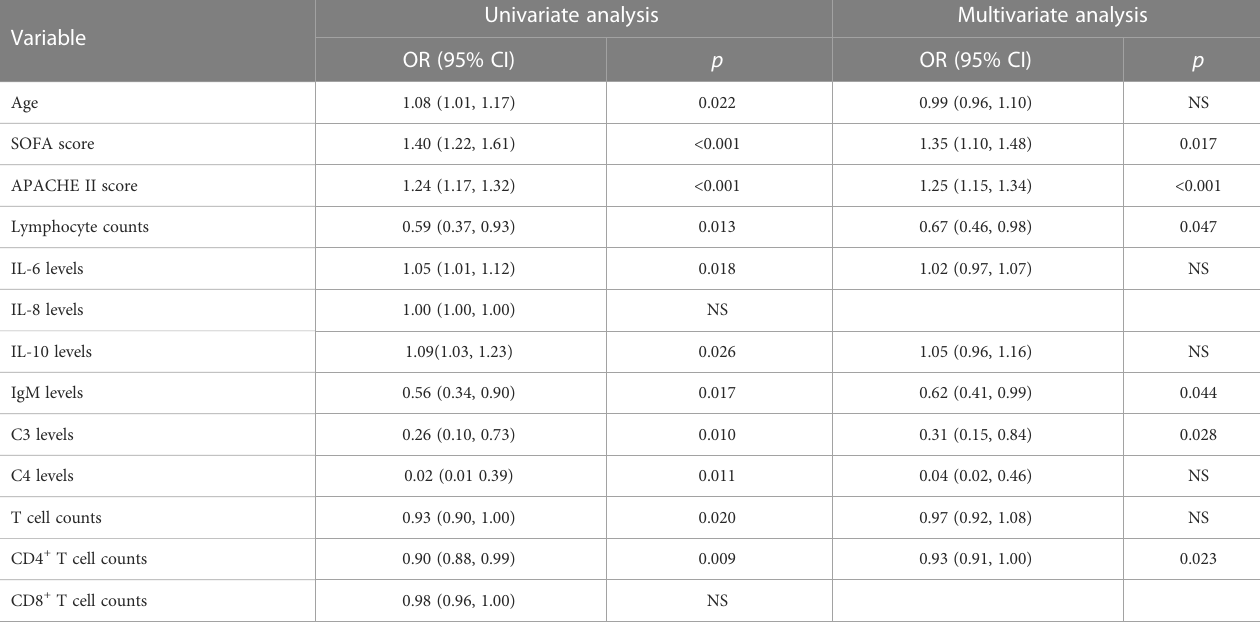
TABLE 2 Univariate and multivariate logistic regression